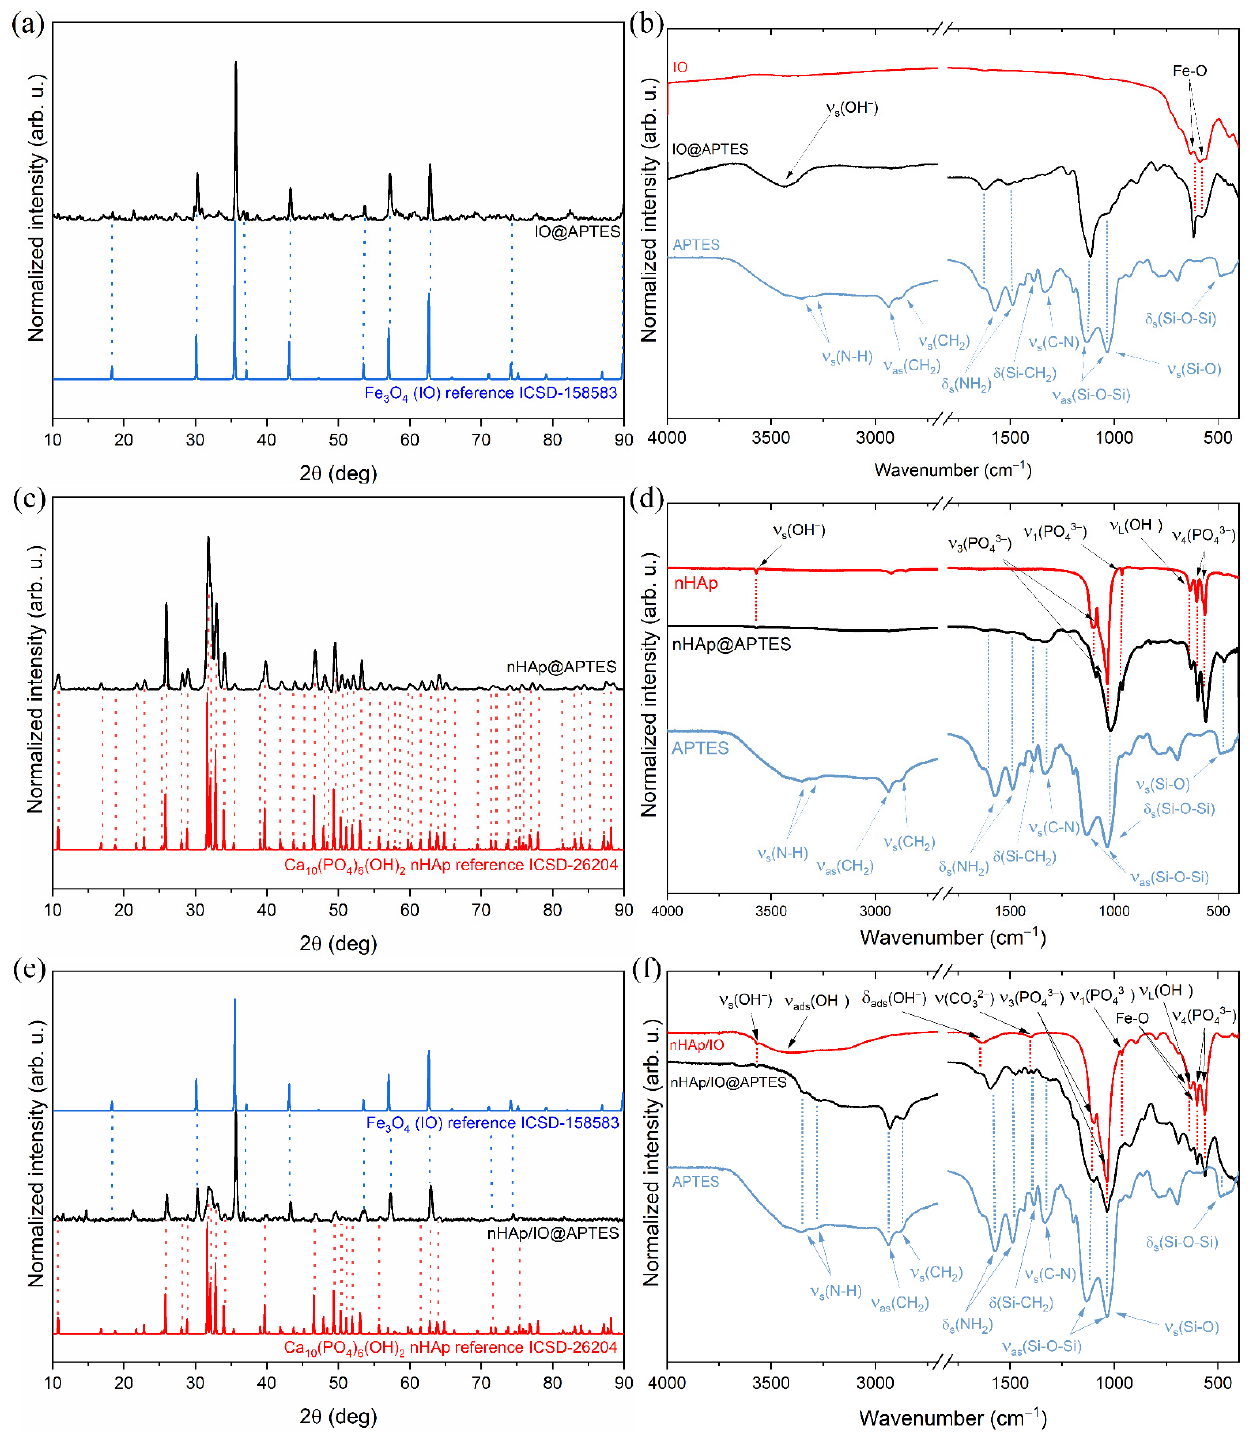
Figure 1. XRD patterns (left panel) and FT-IR spectra (right panel) of pure IO ( a , b ) and IO modified with APTES, pure nHAp and nHAp modified with APTES ( c , d ) as well as nHAp/IO and composite modified with APTES ( e , f ). Pure APTES was marked as blue line.